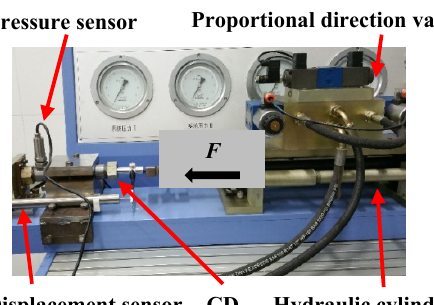
Figure 7. Speed test set-up for the CD.